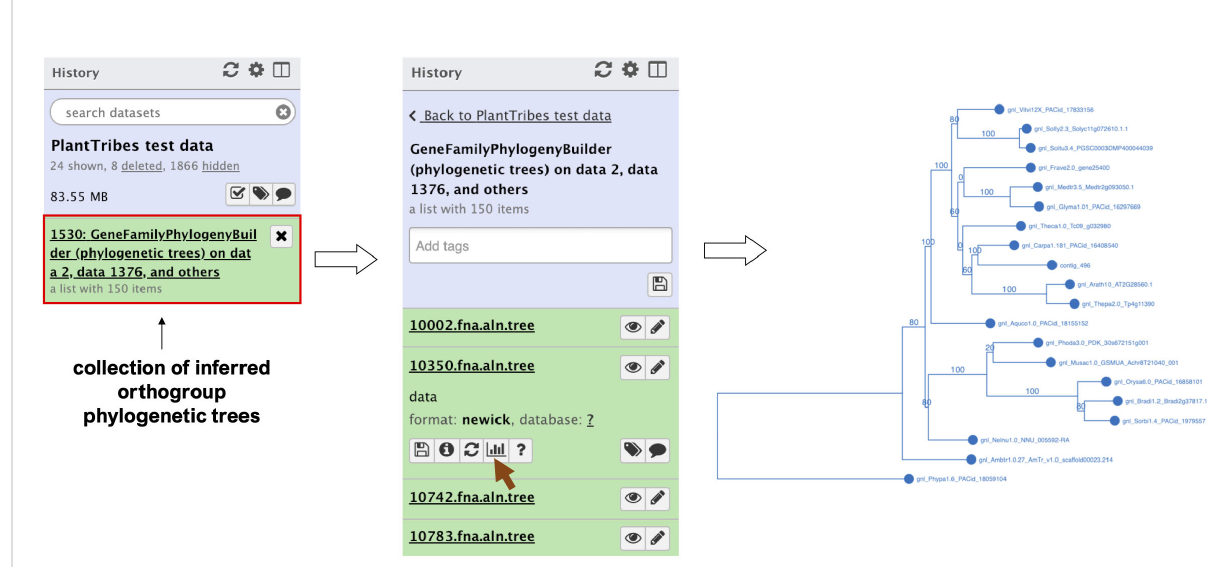
FIGURE 3 An illustration of an orthogroup phylogenetic tree produced by the Galaxy PlantTribes2 GeneFamilyPhylogenyBuilder using the test dataset. Results can be visualized in Galaxy using either the Phylocanvas (demonstrated here) or the PHYLOViZ